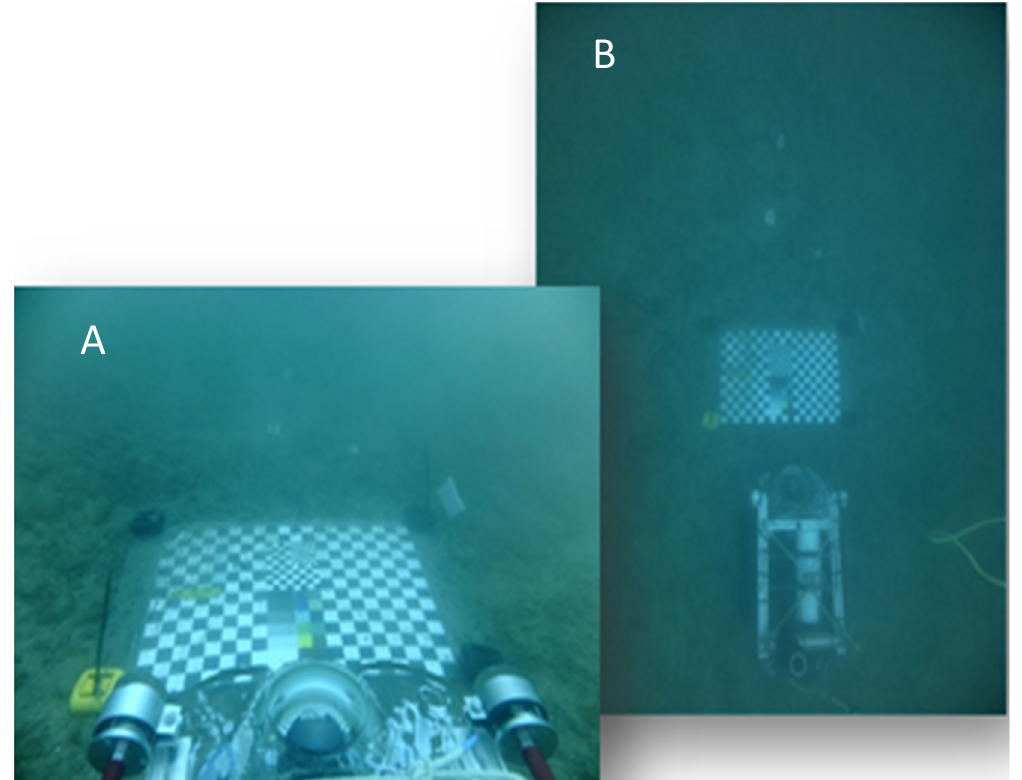
Figure 8. Calibration essays at the OBSEA, with a photo of the checkerboard from the centre viewpoint of the remote vehicle ( A ), and from a higher perspective ( B ).